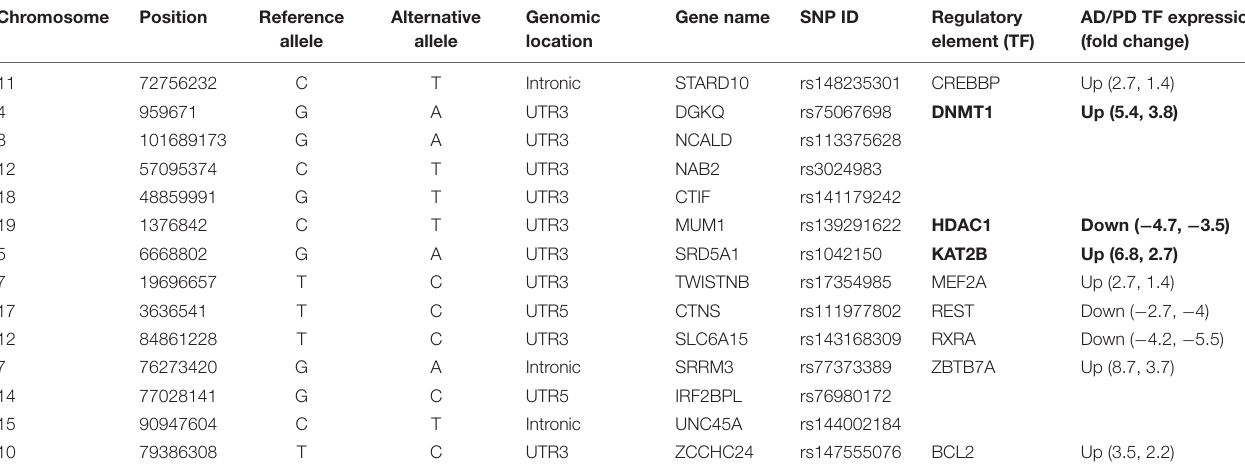
The highlighted genes are involved in histone acetylation and methylation.